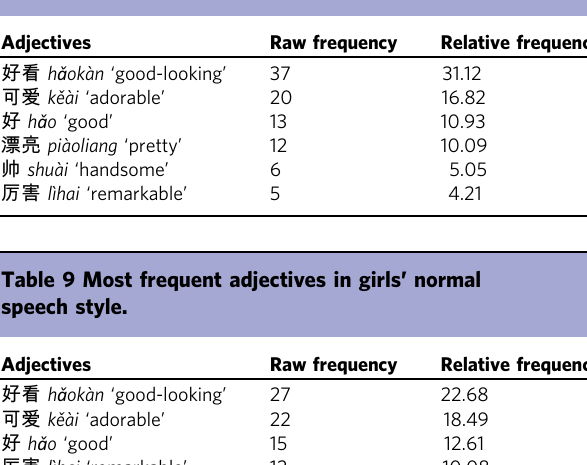
Table 8 Most frequent adjectives in boys ’ imitated feminine speech.